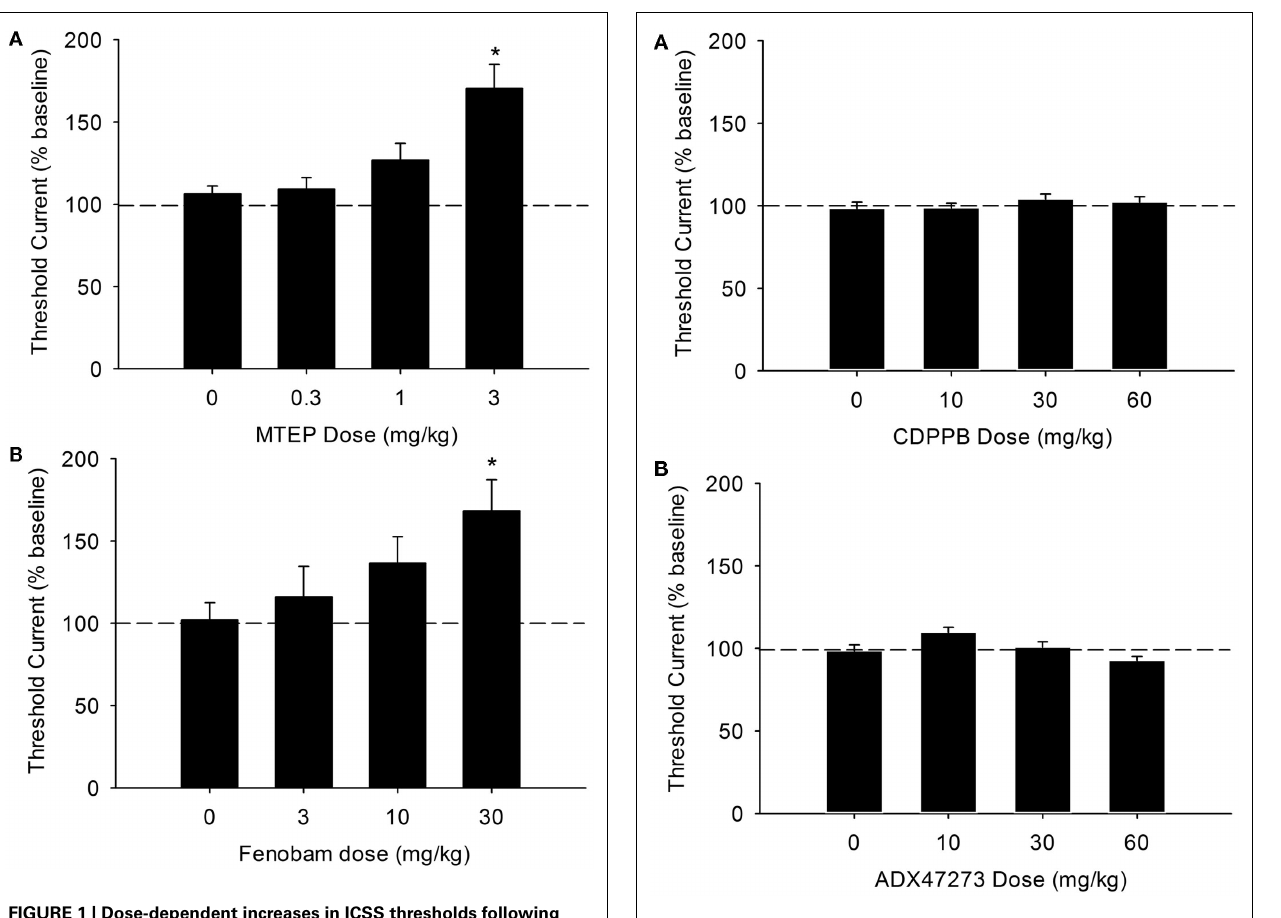
FIGURE 2 |Absence of effects of acute administration of various doses of the mGlu5 PAM CDPPB [(A): n = 15] orADX47273 [(B): n = 15] on ICSS